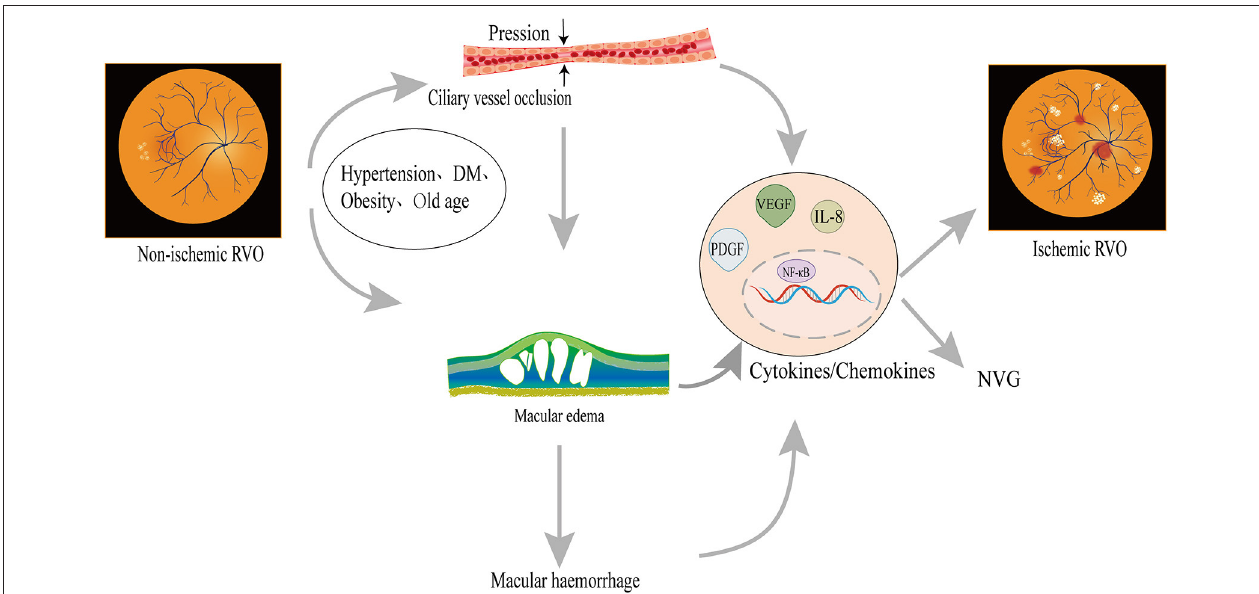
FIGURE 1 | Possible mechanism of non-ischemic CRVO transforming into iCRVO: Non-ischemic CRVO along with cilioretinal artery occlusion may introduce central or peripheral visual field defects, similarly to ischemic CRVO; macular hemorrhage leads to an increase in inflammatory factors, which are involved in the occurrence of iCRVO. The occlusion of ciliary vessels induces hypoxia and VEGF production. Increased VEGF can promote angiogenesis, leading to NVG. Hypertension, advanced age, and obesity are also related to ischemic CRVO.